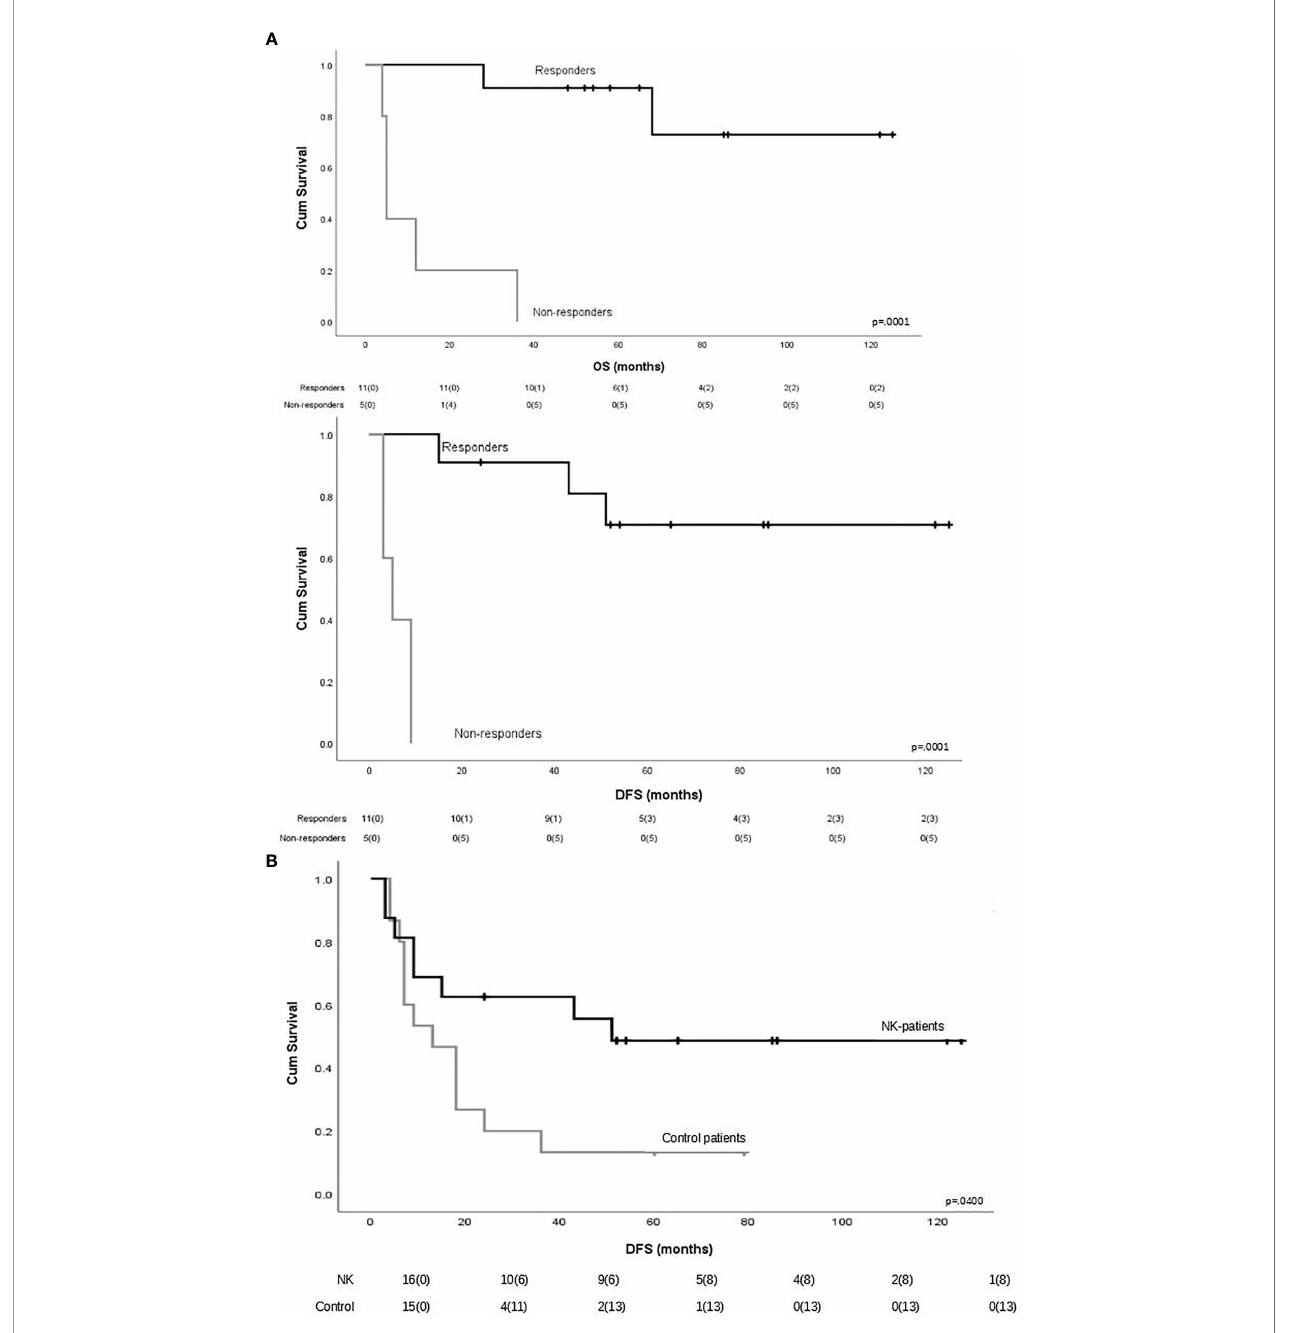
FIGURE 1 | (A) Impact of response to natural killer (NK) cell immunotherapy on long-term outcome in terms of overall survival and disease-free survival. Responders were de fi ned as those patients who maintained CR for at least 6 months after NK cell infusion ( n = 11). Patients maintaining CR after NK cell infusion had a signi fi cantly better outcome as compared with non-responder patients. (B) Long-term disease-free survival in patients who received or did not receive NK